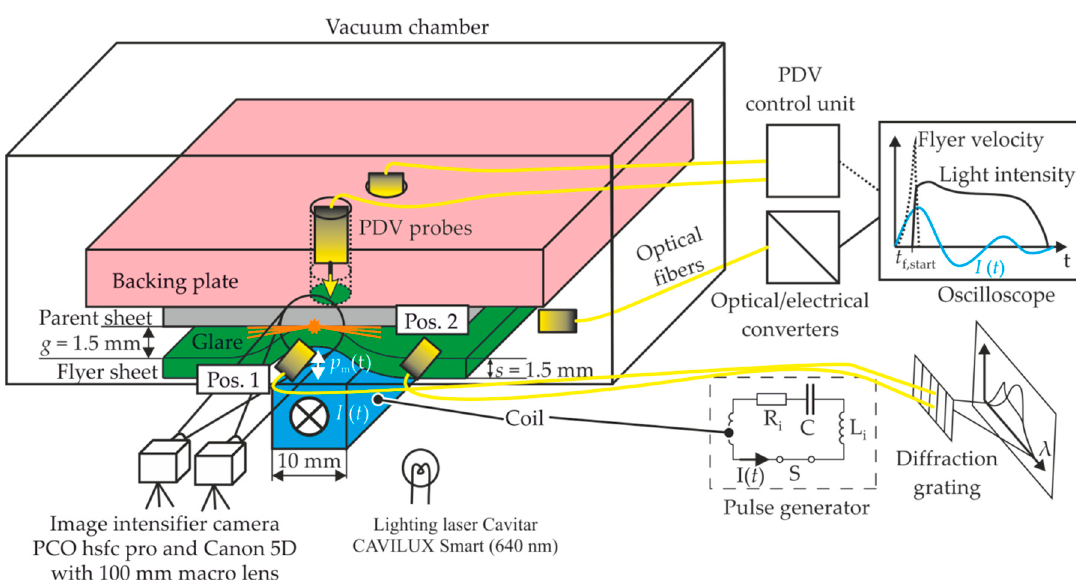
Figure 4. Setup for the analysis of the flyer movement, the formation of the CoP, the flash occurrence, and the emission spectrum in the MPW sheet welding setup.